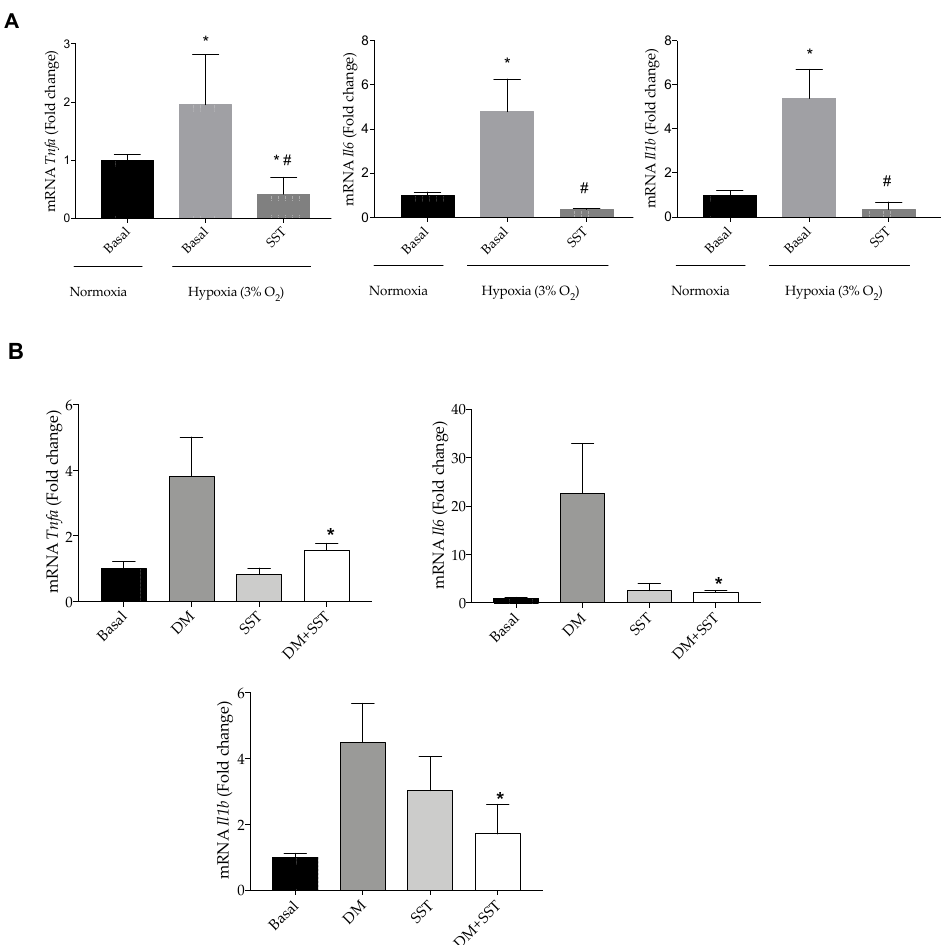
Figure 8. SST decreases pro-inflammatory markers induced by hypoxia and diabetic milieu in Bv.2 cells. ( A ) E ff ect of SST in the expression of pro-inflammatory parameters in hypoxia (3% O 2 )-stimulated Bv.2 microglial cells. Bv.2 cells were pre-treated for 4 h with SST (10 − 6 M) and then cultured under hypoxia (3% O 2 ) for 24 h. mRNA levels of Tnfa , Il1b and Il6 were determined by RT-PCR. The results are means ± S.E.M (n = 5 independent experiments). * p ≤ 0.05 vs. basal normoxia condition; # p ≤ 0.05 vs. basal hypoxia condition (one-way ANOVA followed by Bonferroni t -test. ( B ) E ff ect of SST in the expression of pro-inflammatory markers in Bv.2 cells stimulated with 25 mM glucose + 300 µ M H 2 O 2 + 20 ng / mL IL-1 β (referred as diabetic milieu: DM). Bv.2 microglial cells were pre-treated for 4 h with SST (10 − 6 M) and then cultured under the diabetic environment of the DM for a further 24 h. Tnfa , Il1b and Il6 mRNA levels were determined by RT-PCR. The fold change relative to the basal condition is shown (n = 3 independent experiments). * p ≤ 0.05 vs. diabetic milieu treatment (two-way ANOVA followed by Bonferroni t -test).